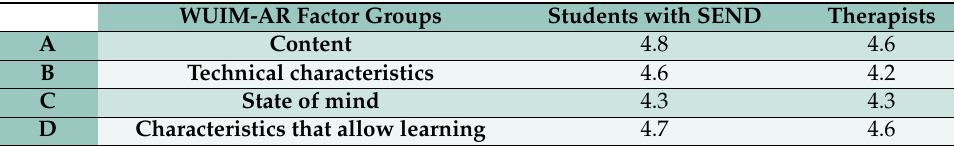
Table 4. Results of WUIM-AR user-based and content expert-based evaluation.